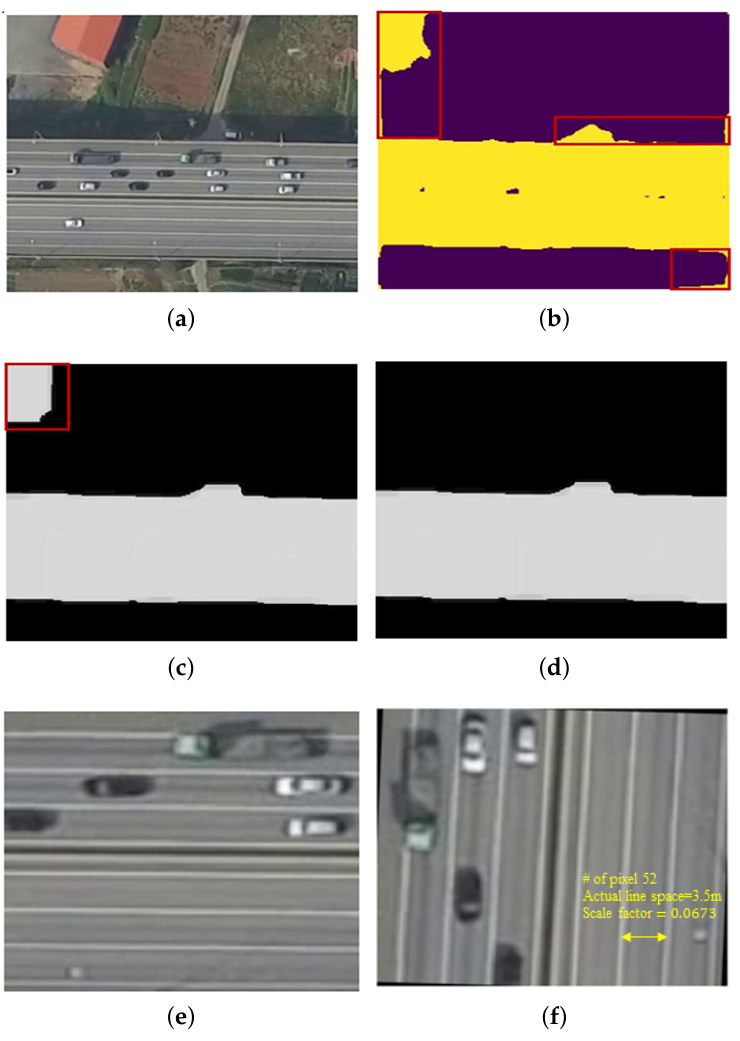
Figure 5. Segmentation result pre-processing. ( a ) road area; ( b ) U-net segmentation; ( c ) image morphology; ( d ) calibrated image; ( e ) resizing image; ( f ) rotated